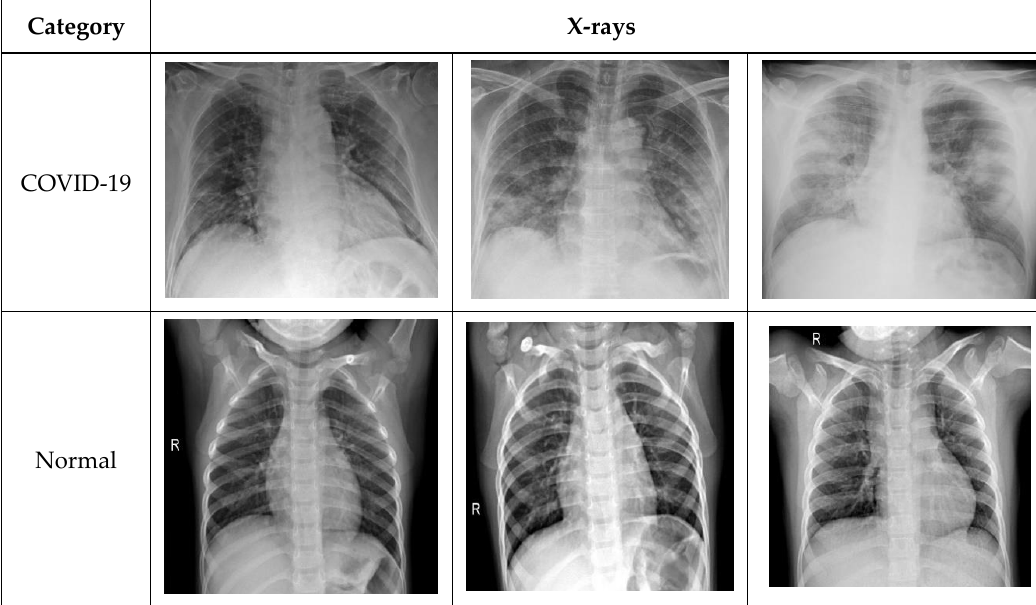
Figure 2. Chest X-ray sample images from the data set used in the study.